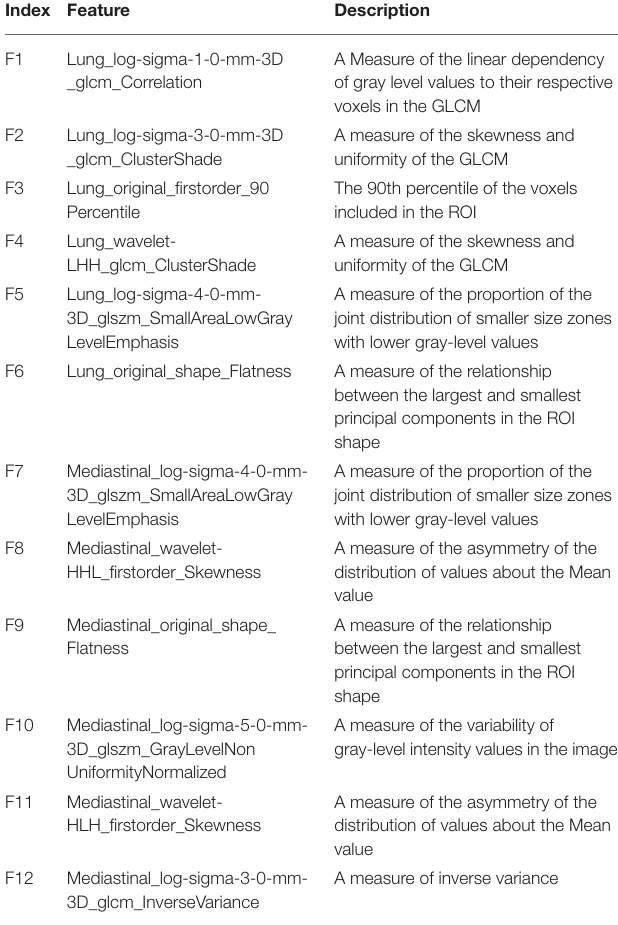
TABLE 2 | Description of the selected radiomic